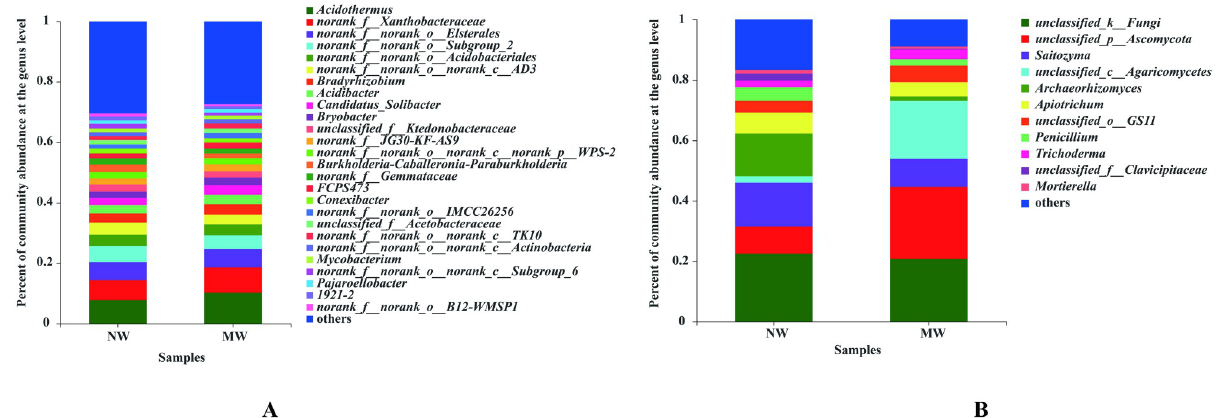
Fig 3. Compositions of soil bacterial (A) and fungal (B) communities at the genus level in star anise plantations between the NW and MW treatments. Note . Only the genera with relative abundances greater than 1% are presented in Fig 3. NW: no weeding in the star anise plantation, and MW: mechanical weeding in the star anise